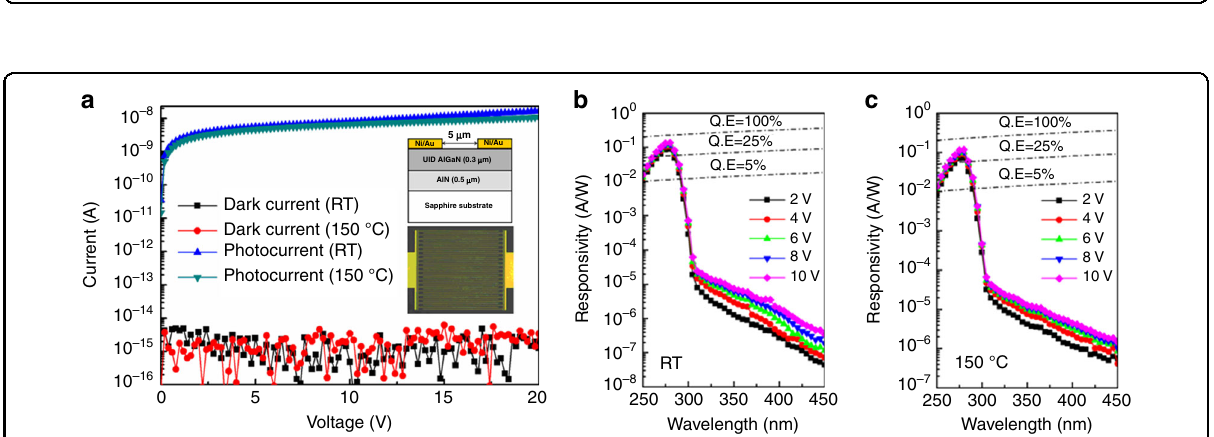
Fig. 11 Structure and performance of a Schottky metal-semiconductor-metal photodetector. a I-V curves of the MSM detectors measured in dark and under 254 nm UV illumination at RT and 150 °C conditions, respectively. Spectral response of the devices measured at b RT and c 150 °C. Reprinted with permission from Xie et al. 182 . Copyright 2012 IEEE